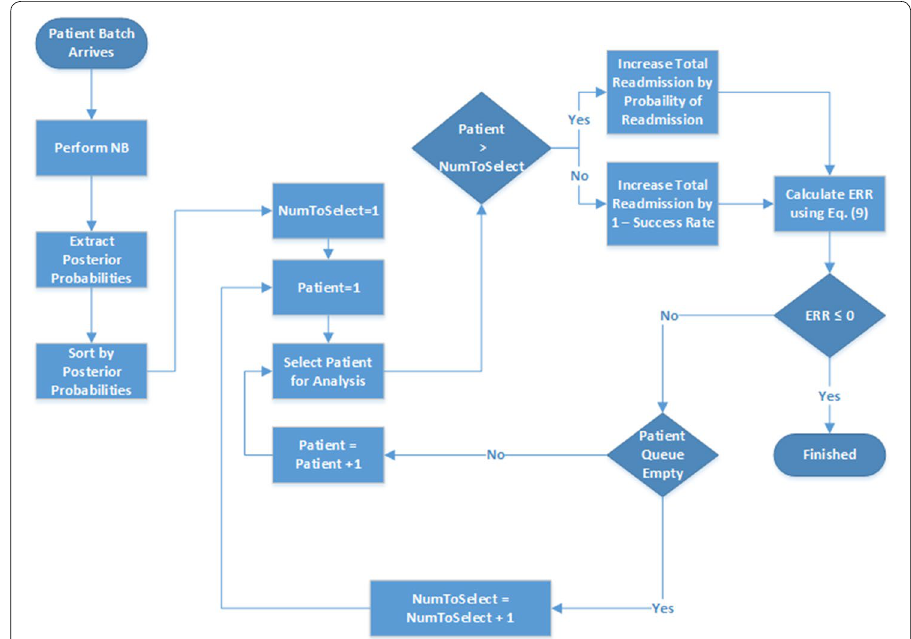
Fig. 3 Flowchart of selecting optimal number of patients for which to provide post-discharge